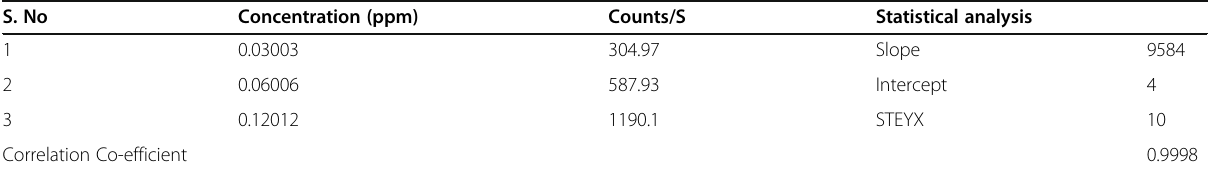
Table 12 System suitability results of